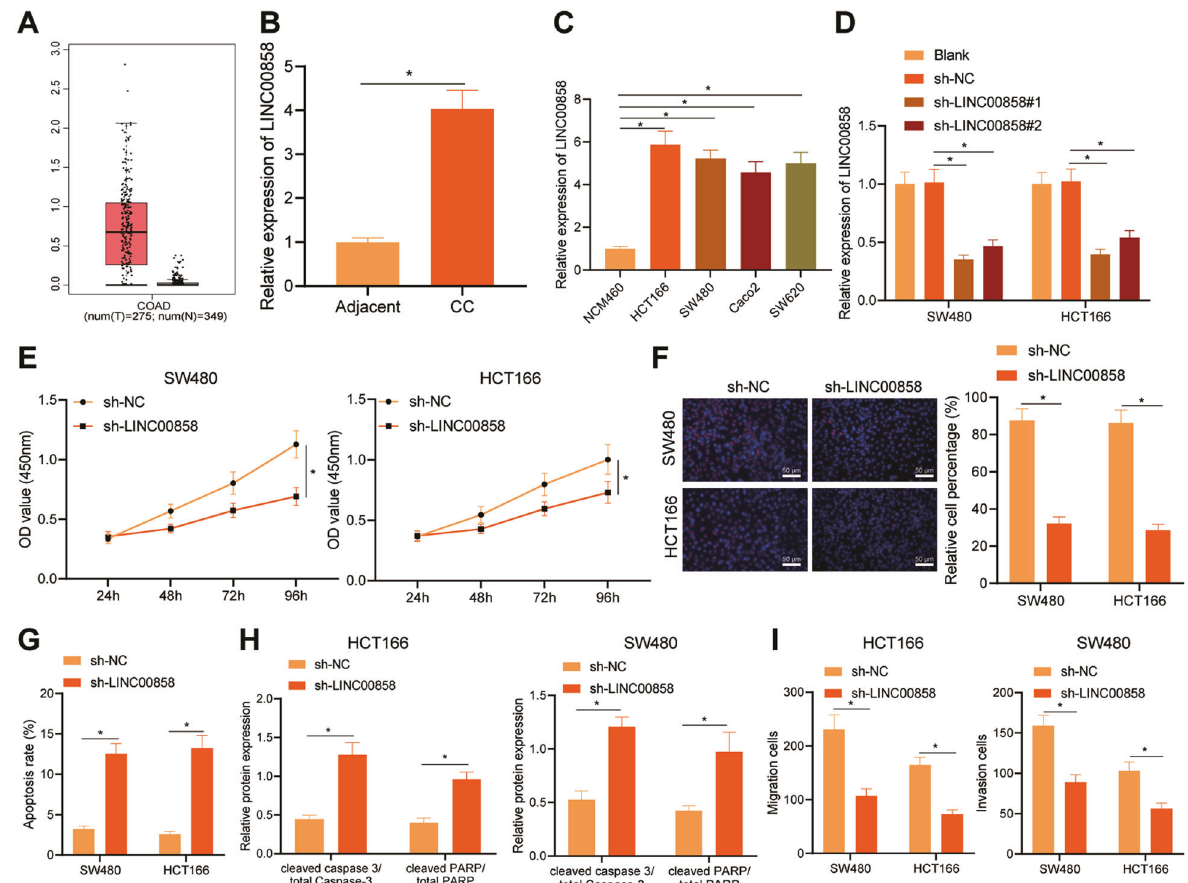
Fig. 1 LINC00858 is highly expressed in colon cancer and silencing of LINC00858 inhibits proliferation, migration, and invasion of colon cancer cells. A LINC00858 expression in colon cancer determined in-silico using GEPIA. Red boxes represent CC samples, and the gray boxes represent normal samples. B Expression of LINC00858 in cancer tissues and normal adjacent tissues of patients with colon cancer ( n = 50) quanti fi ed by RT-qPCR, * p < 0.05 vs. normal adjacent tissues. C LINC00858 expression in human normal colon cell line (NCM460) and colon cancer cell lines (HCT166, SW480, Caco2 and SW620) quanti fi ed by RT-qPCR. * p < 0.05 vs. * p < 0.01 vs . NCM460 cell line. D The expression of LINC00858 in SW480 and HCT166 cells quanti fi ed by RT-qPCR. E CCK-8 assay for measuring the viability of SW480 and HCT166 cells in each group. F EdU staining to determine the proliferation of SW480 and HCT166 cells in each group. G TUNEL staining to detect the apoptosis of SW480 and HCT166 cells in each group. H Western blot assay to detect the expression of apoptosis related proteins cleaved caspase-3/total Caspase 3 and cleaved PARP/total PARP in SW480 and HCT166 cells from each group. I Transwell assay to assess the migration and invasion abilities of SW480 and HCT166 cells in each group. * p < 0.05. Statistical comparisons between adjacent tissues and cancer tissues were conducted using paired t test and other two group data were compared using unpaired t test. Data from multiple groups were compared using one-way ANOV with Tukey ’ s post hoc tests. Repeated measures ANOVA with Bonferroni ’ s post hoc test was used to compare data obtained at different time points,. All cell experiments were repeated three veri fi ed by RT-qPCR results (Fig. 1B) that colon cancer tissues presented an obvious higher LINC00858 expression than adjacent tissues. Moreover, we observed higher LINC00858 expression in the four used colon cancer cell lines (HCT166, SW480, Caco2, and SW620) relative to that in NCM460 normal colon cell line. SW480 and HCT166 cells were selected for subsequent experiments due to their higher LINC00858 expression among the colon cancer cell lines (Fig. 1C). For investigating the effects of LINC00858 on the cancerous cell function, we knocked down LINC00858 in SW480 and HCT166 cells. RT-qPCR results showed that, relative to cells used as blank